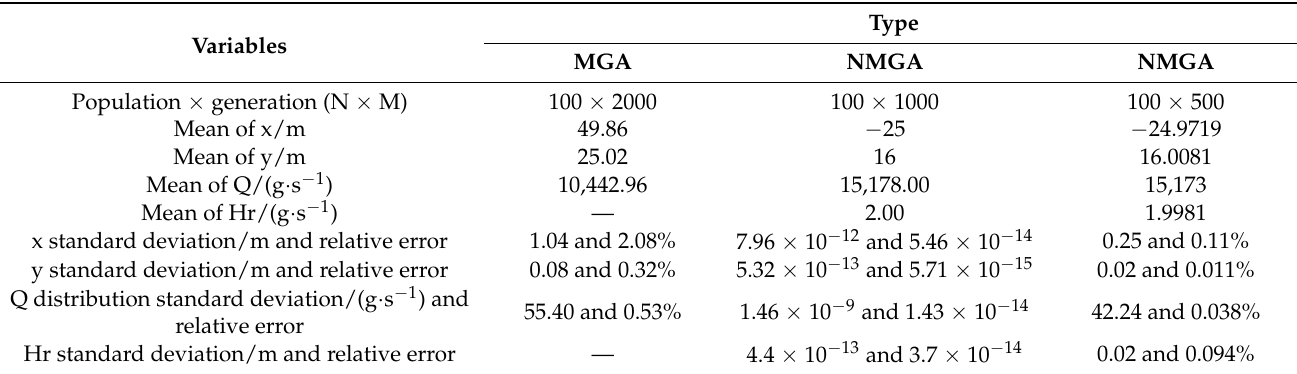
Table 1. Statistical analysis results for 100 independent MGA or NMGA calculations with different